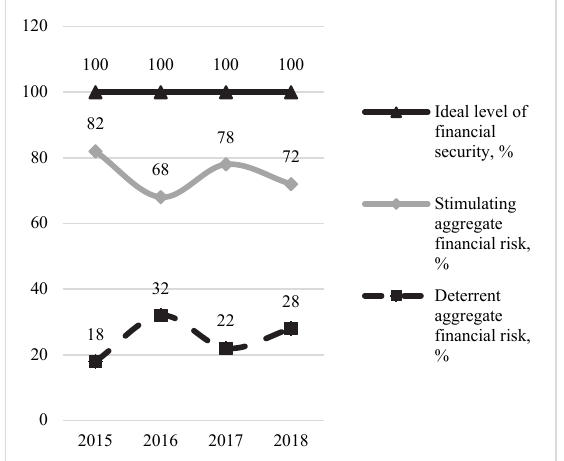
Fig. 5. Impact of restraining financial risk on the financial security level of PJSC “SKF Ukraine” in 2015-2018, %*